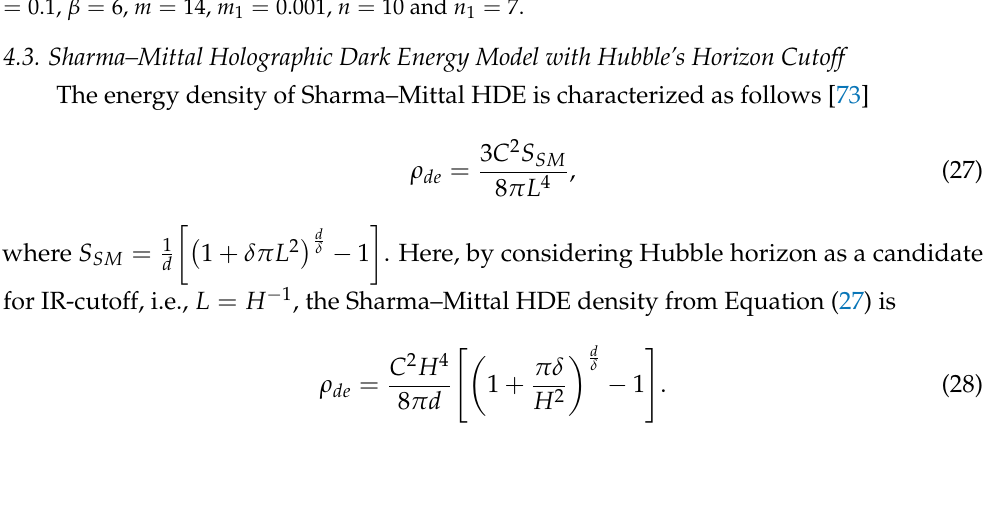
Figure 4. Behavior of EoS parameter of Tsallis holographic dark energy density of f ( T , B ) gravity model in Hubble’s horizon cutoff versus redshift for the appropriate choice of constants d = 1.82, = 0.1, β = 6, m = 14, m = 0.001, n = 10 and n = 1 1